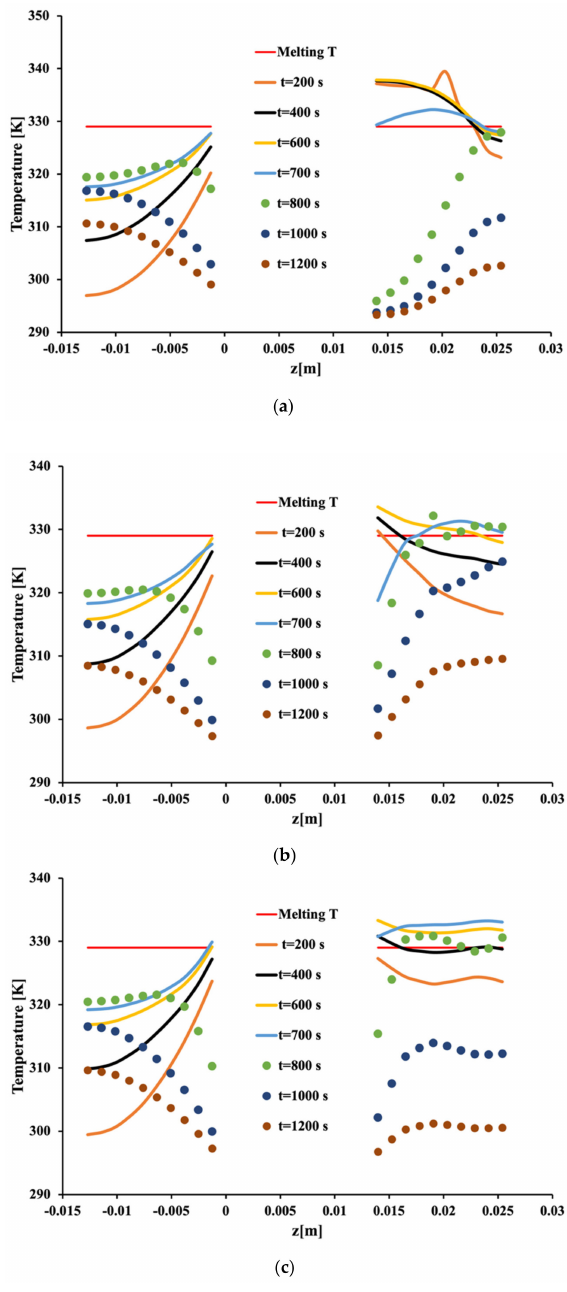
Figure 9. Temperature distribution along the z-axis in the middle of the phase change material. (With no pin-fins, ( a ) Re = 50, ( b ) Re = 100, ( c ) Re =